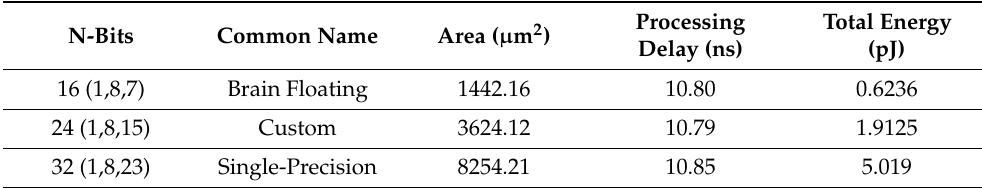
Table 6. Comparison of N-bit floating-point divider.